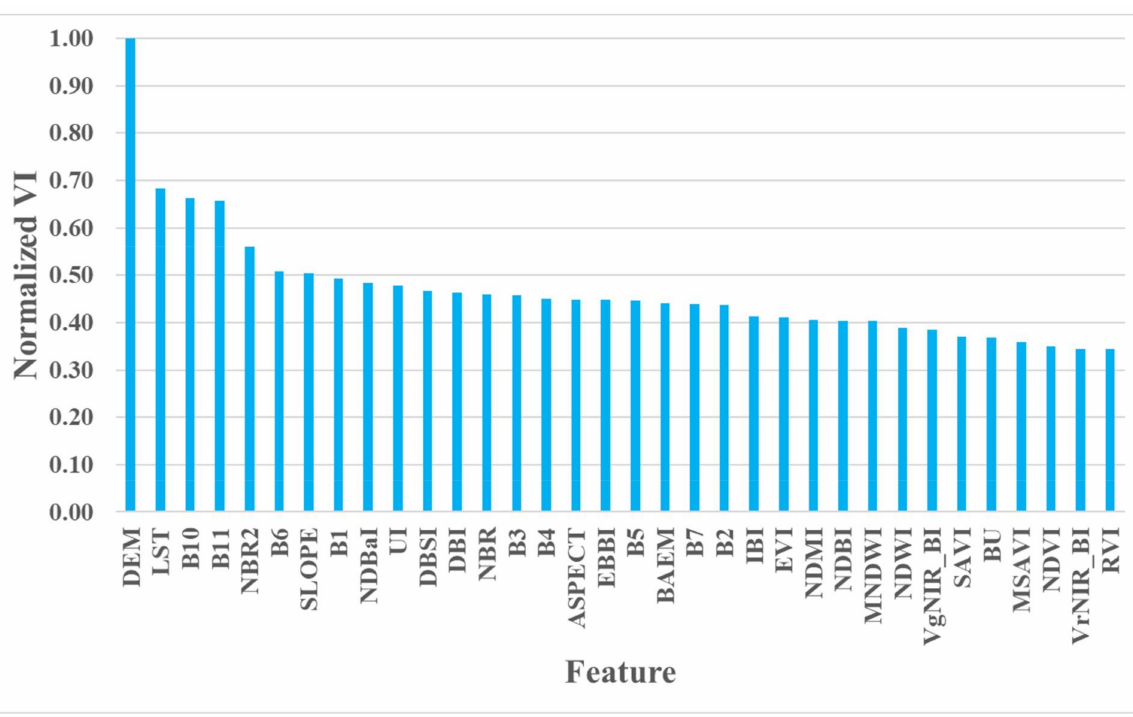
Figure 6. The average of normalized feature (variable)